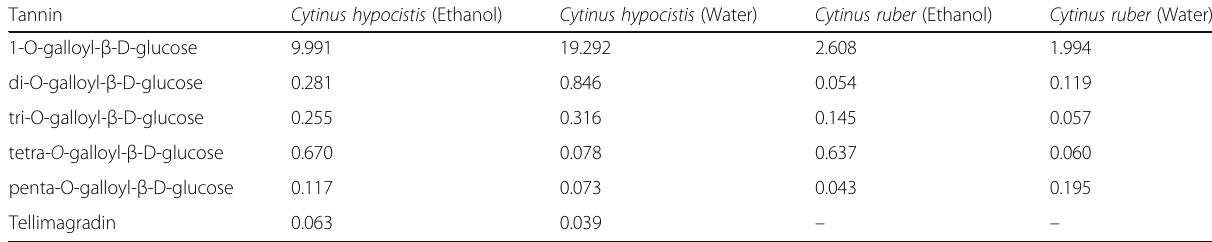
Table 3 Levels of tannins in Cytinushypocistis and Cytinusruber extracts (g/kg)